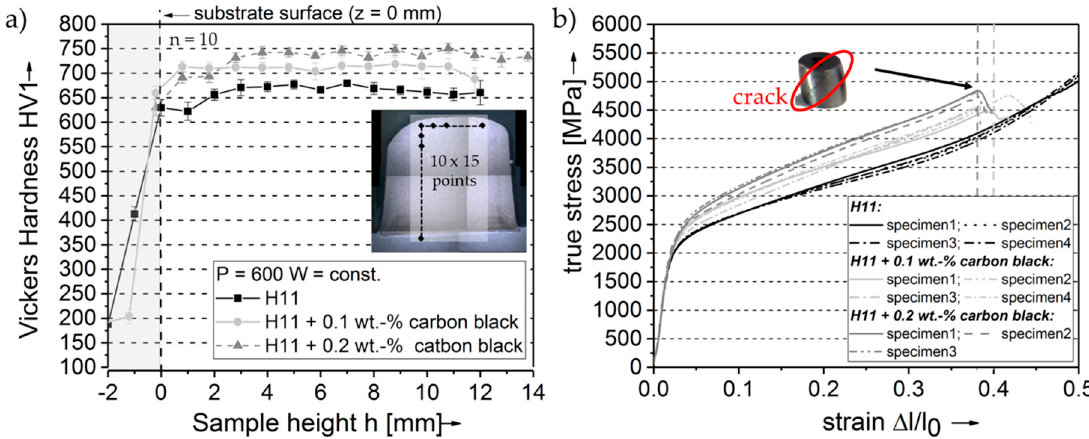
Figure 15. ( a ) Hardness profiles as function of the sample height for 35-layered samples after annealing and prior to the mechanical finishing and ( b ) stress-strain curves of the tested specimens.